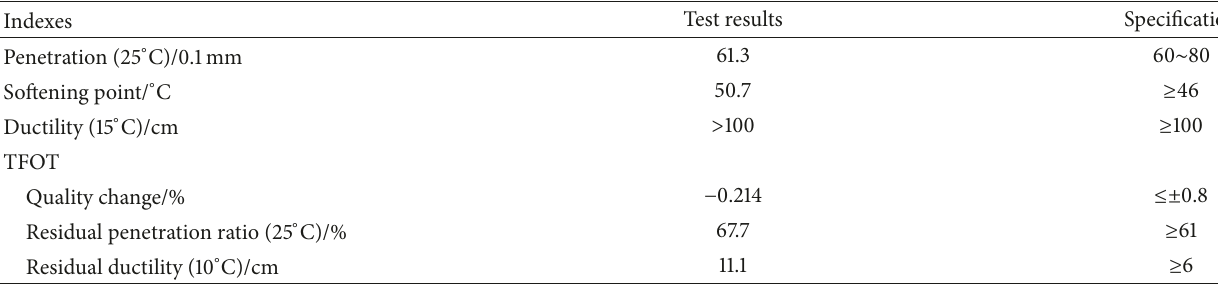
Table 1: Main technical indexes of matrix asphalt.